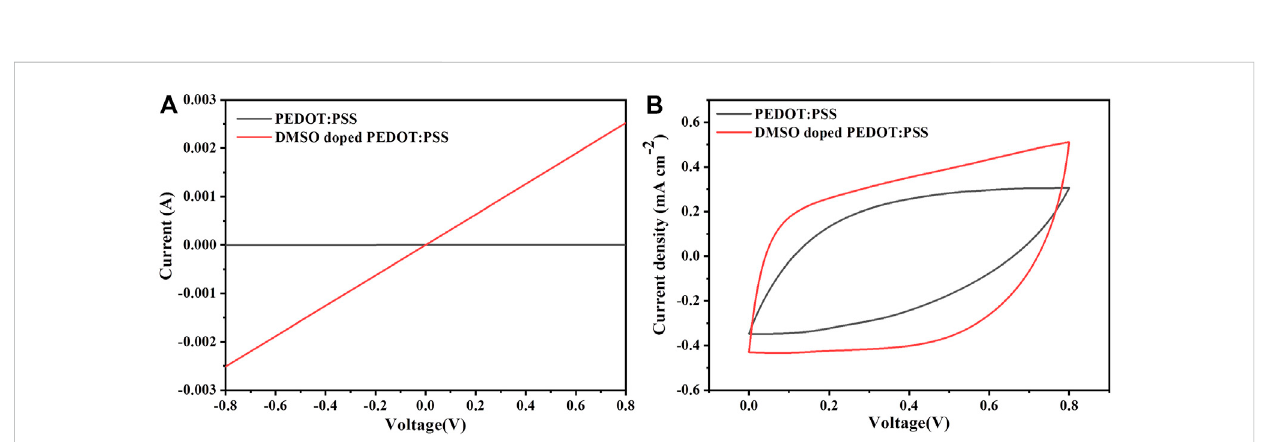
FIGURE 3 (A) I-V curves of the electrodes prepared with pure PEDOT:PSS and DMSO doped PEDOT:PSS. (B) CV curves (at 100 mV s − 1 ) of the MSCs with electrodes prepared with pure PEDOT:PSS and DMSO doped